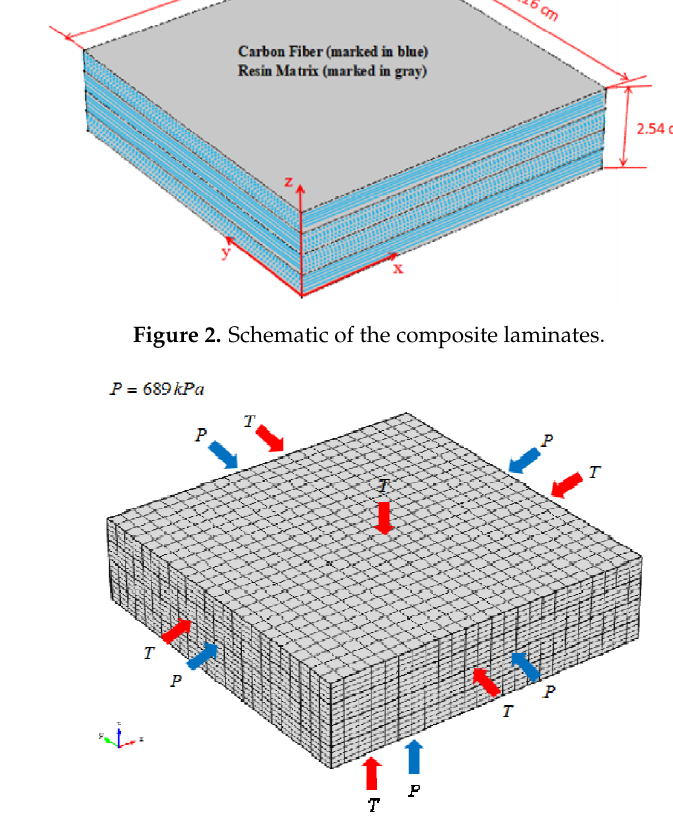
Figure 3. Meshing and boundary conditions of the composite laminates .